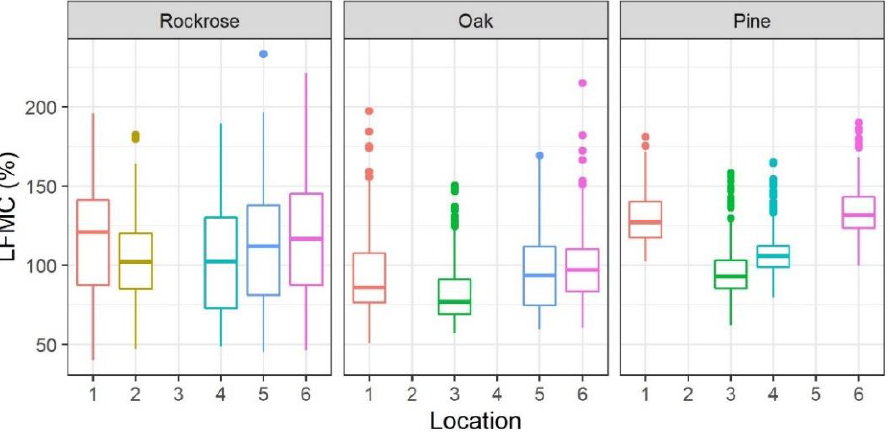
Figure 2. Live fuel moisture content (LFMC) variability across species and sampled locations (2016–2021). Boxplots show median values, and dots are outliers.